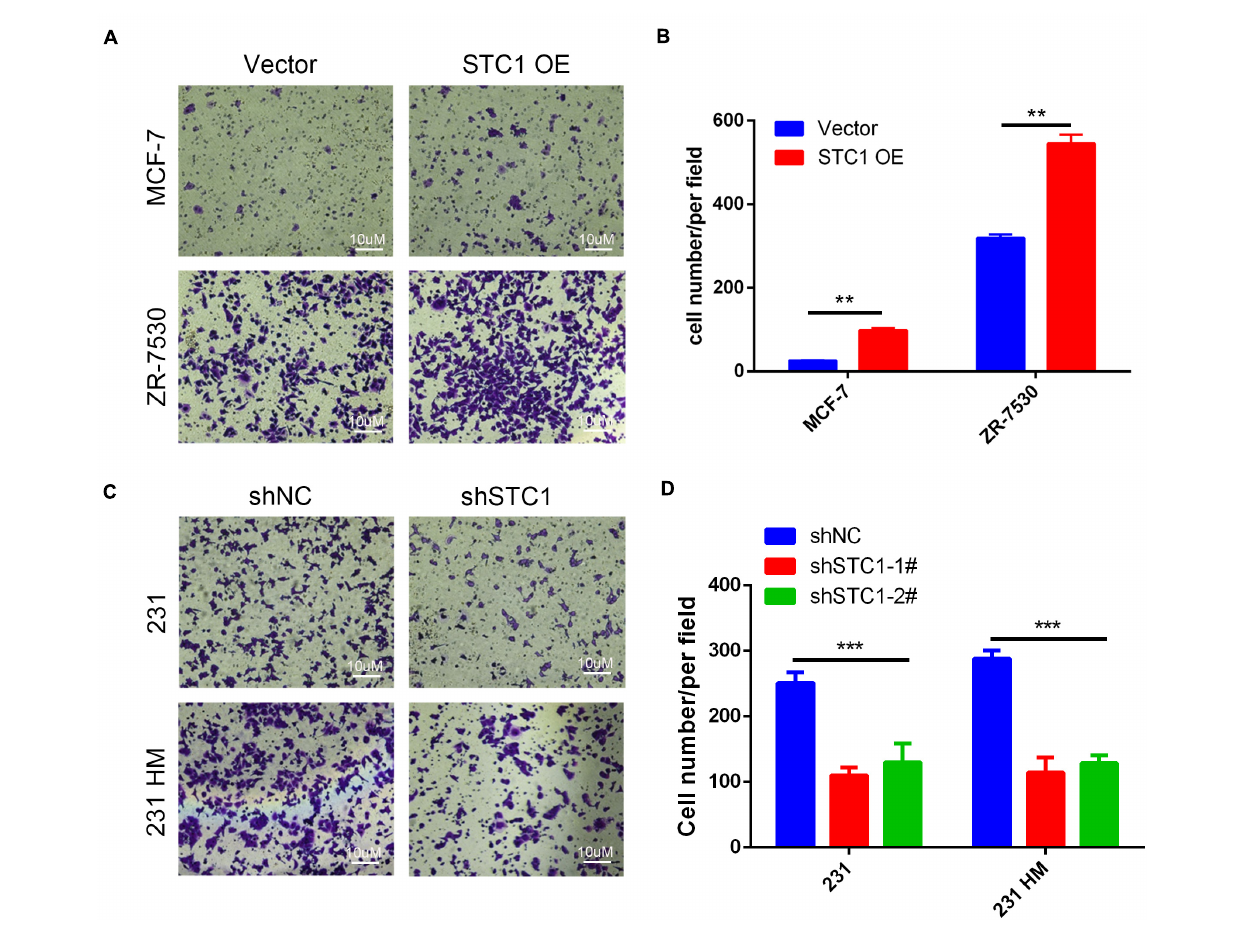
FIGURE 2 | Stc1 influences the migration of breast cancer cells. (A–D) Migration assays. MCF-7 STC1 or ZR-7530 STC1 cells or 231 shSTC1 or 231 HM shSTC1 cells and their corresponding control cells were added in each upper chamber of a high-throughput screening multi-well insert 24-well two-chamber plate and allowed to migrate at 37 ◦ C for 6–12 h toward a lower reservoir containing a medium plus 2.5% fetal bovine serum. The invaded cells were fixed with ice-cold methanol for 30 min, stained with 0.1% crystal violet for 15 min, photographed, and counted at × 200 magnification under a microscope. (A,C) Representative images of migrated cells; (B,D) quantitative analysis of the number of migrated cells. Data are shown as mean ± SEM from three independent experiments. P -value was determined by two-tailed unpaired t -test (** P < 0.01; *** P <